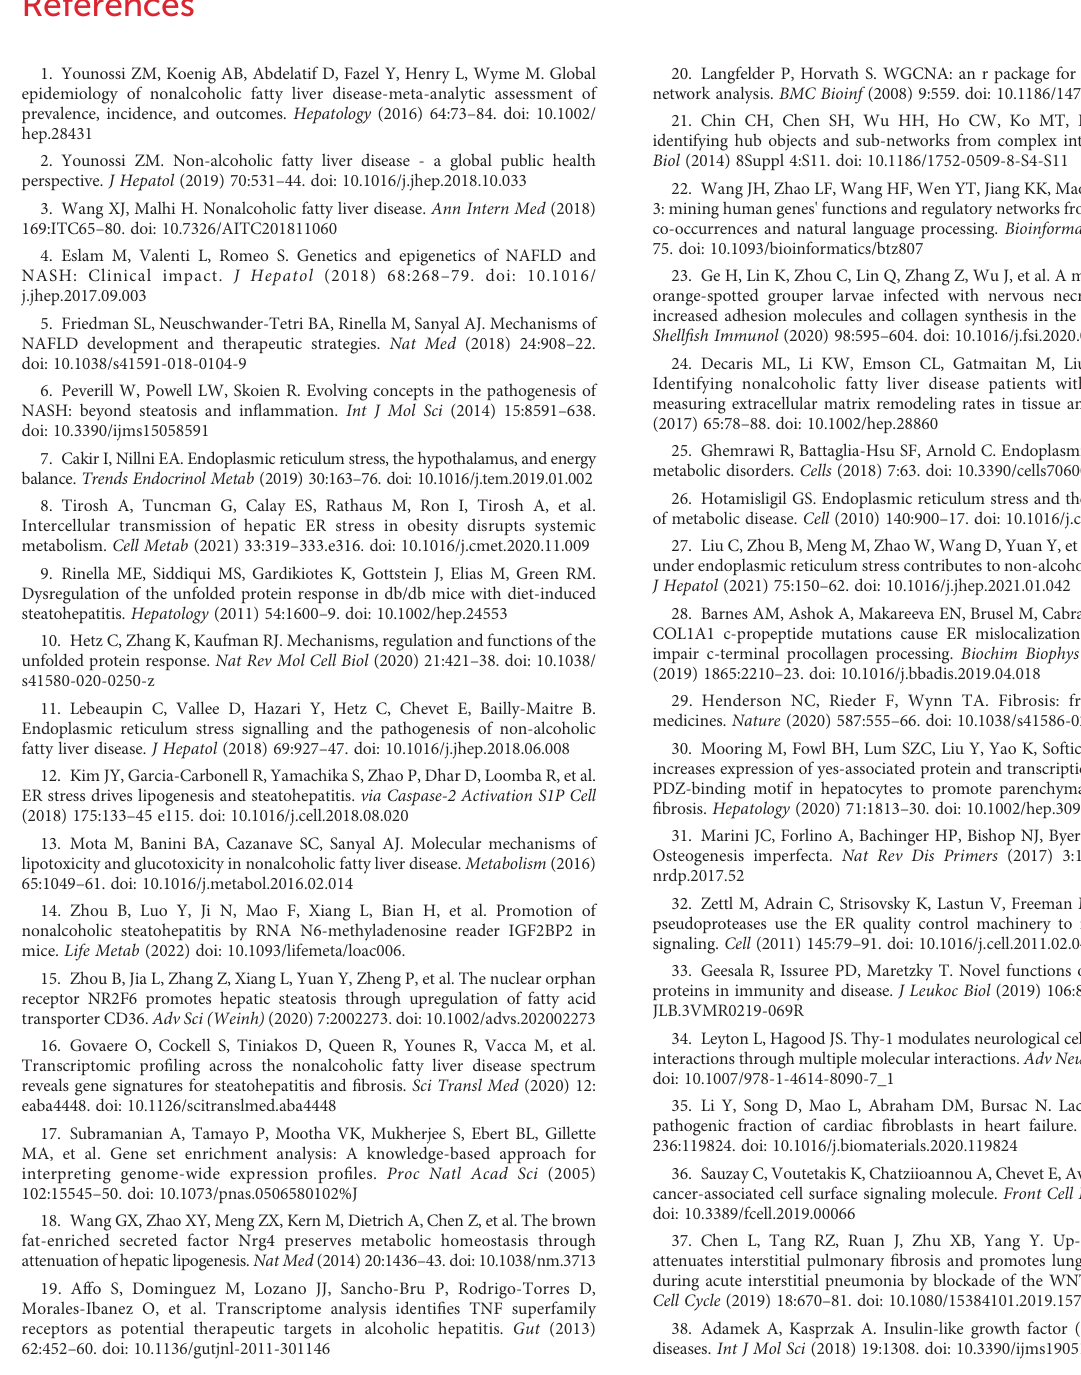
SUPPLEMENTARY FIGURE 1 Selection of ER related gene sets and sample clustering. (A) Upset plot summarizes the intersection among ER related gene sets. The bar plot in the left represents the gene number of each set. The lines in the right